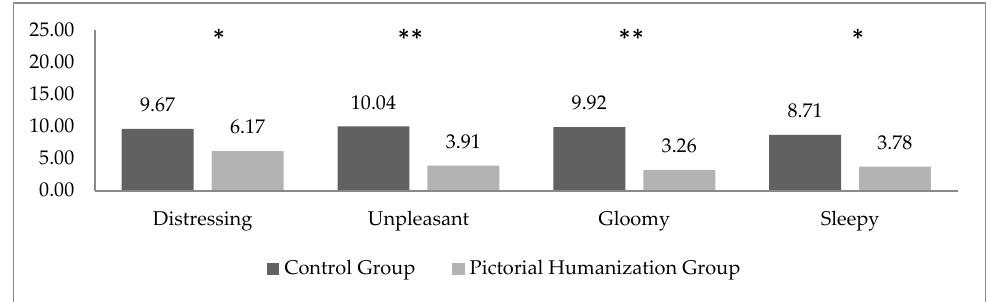
gloomy (F(1,45) = 10.808; p = 0.002) and sleepy (F(1,45) = 7.073; p = 0.011) (Figure 2).